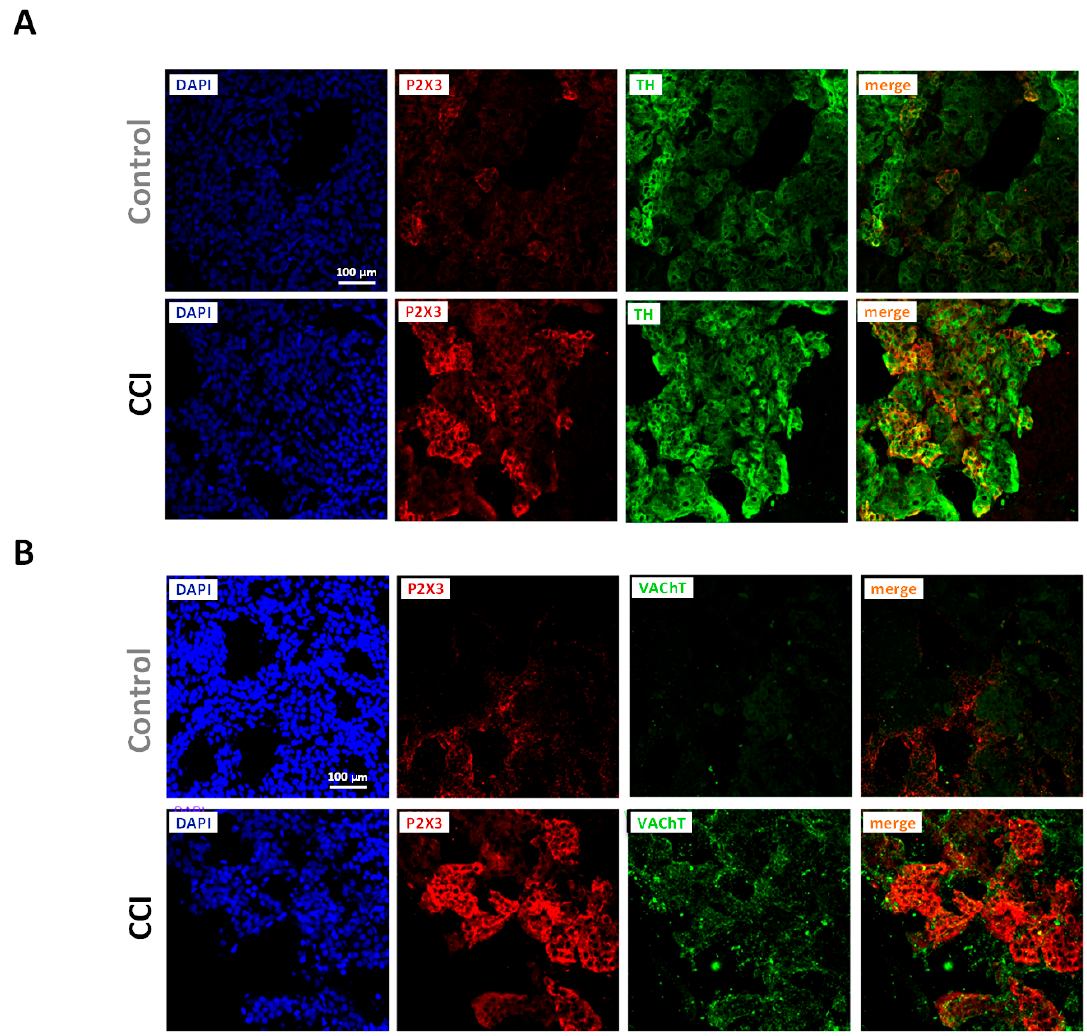
Figure 6. Increased P2X3 receptor immunoreactivity in chromaffin cells from CCI animals. ( A ) Fluorescence confocal images of adrenal glands from Control (upper panels) and CCI animals (lower panels) stained for P2X3 receptor and tyrosine hydroxylase (TH). ( B ) Fluorescence confocal images of adrenal glands from Control (upper panels) and CCI animals (lower panels) stained for P2X3 receptors and the vesicular acetylcholine transporter (VAChT). Cell nuclei in ( A , B ) were visualized following incubation with DAPI. Images are representative of those obtained from 3 Control and 3 CCI animals.